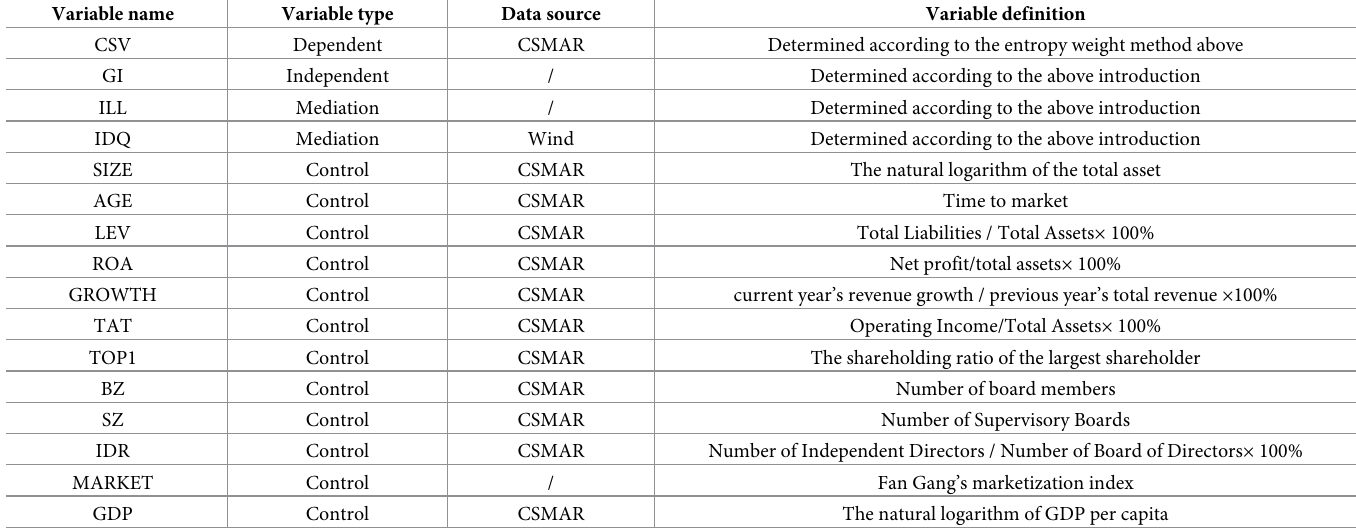
Table 3. The variable definition table used in this